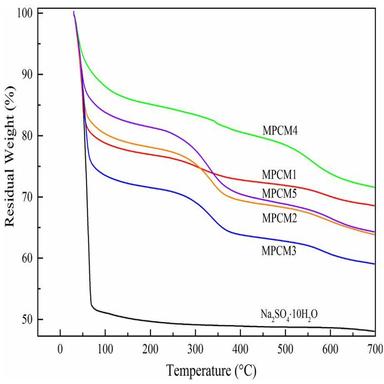
TGA curves for Na2SO4·10H2O and MPCM1–MPCM5.